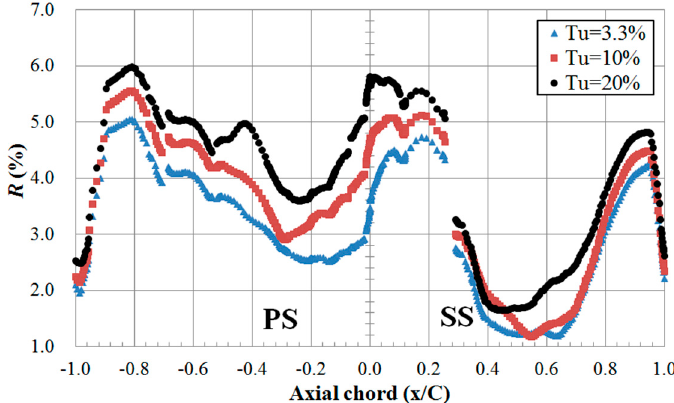
Figure 9. Effect of Tu on the percentage of temperature reduction ( R ) at midspan.